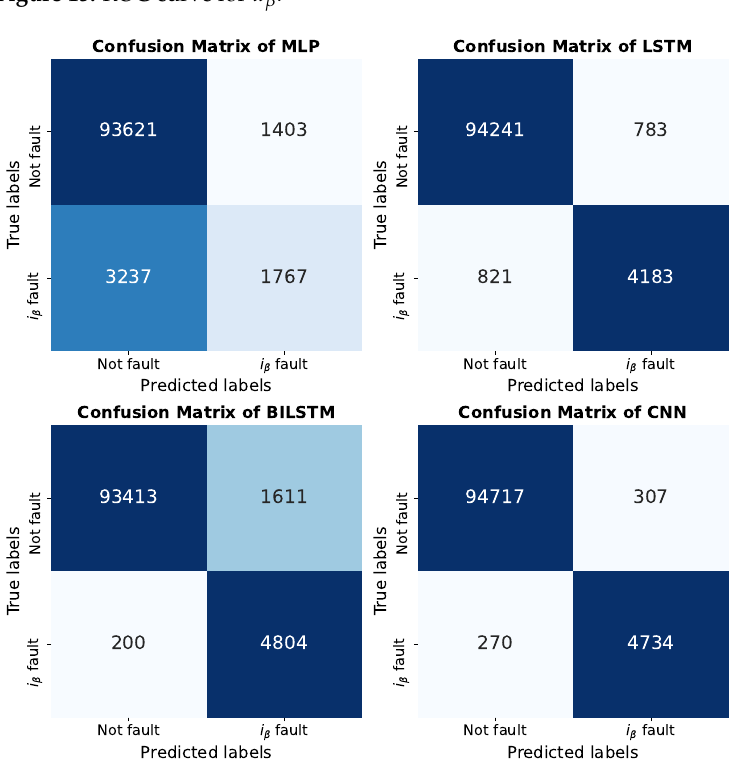
Figure 16. Confusion matrix plot for Channel 3 with 10-d delayed vector. True positive: Neuronal classifier correctly predicted no failure. True negative: Neuronal classifier correctly predicted failure. False positive: Neuronal classifier incorrectly predicted no failure. False Negative: Neuronal classifier incorrectly predicted